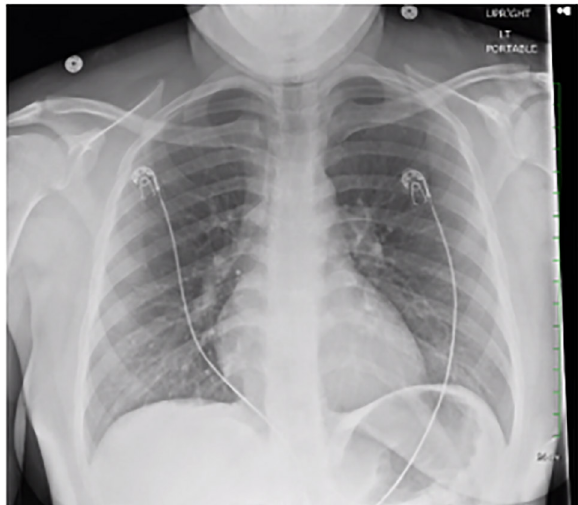
Image 2. Portable upright anterior-posterior chest radiograph not demonstrating appreciable cardiopulmonary